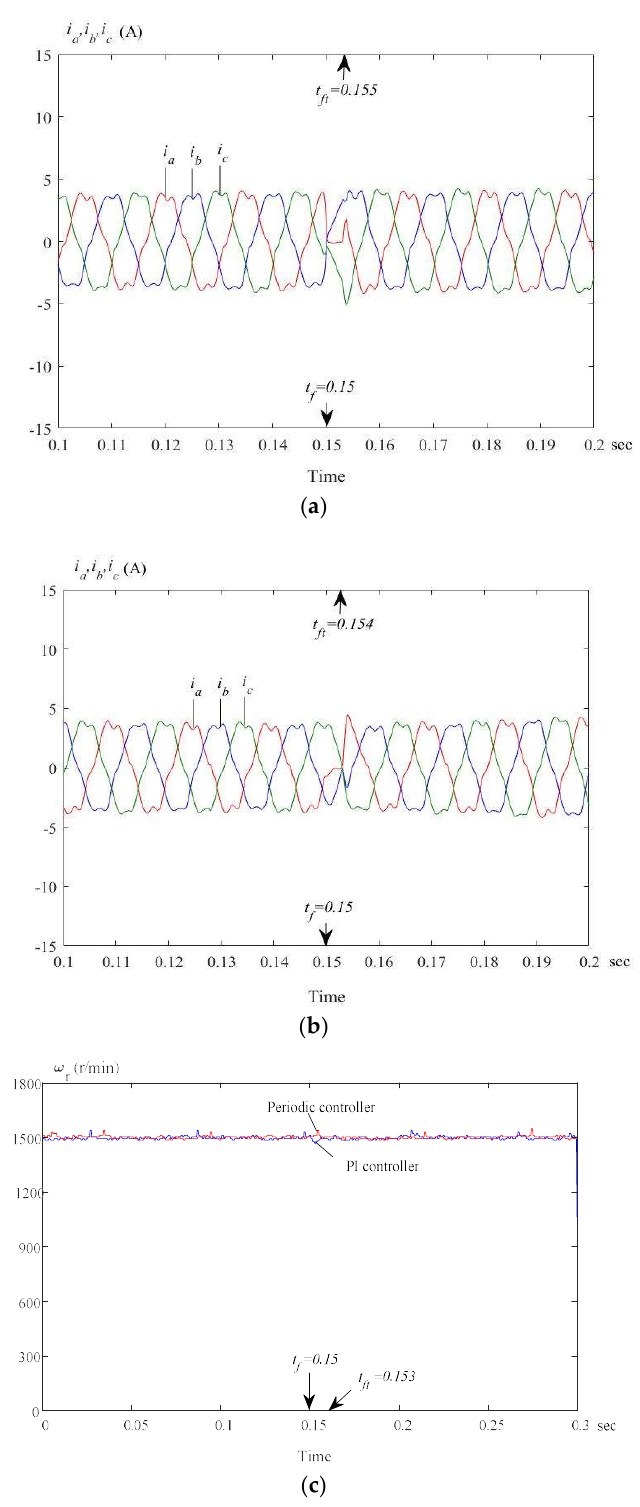
Figure 16. Measured results at 1500 r / min of the fault-tolerant control when the a -phase was open-circuited: ( a ) currents of the PI controller; ( b ) currents of the periodic controller; ( c ) speed-responses.